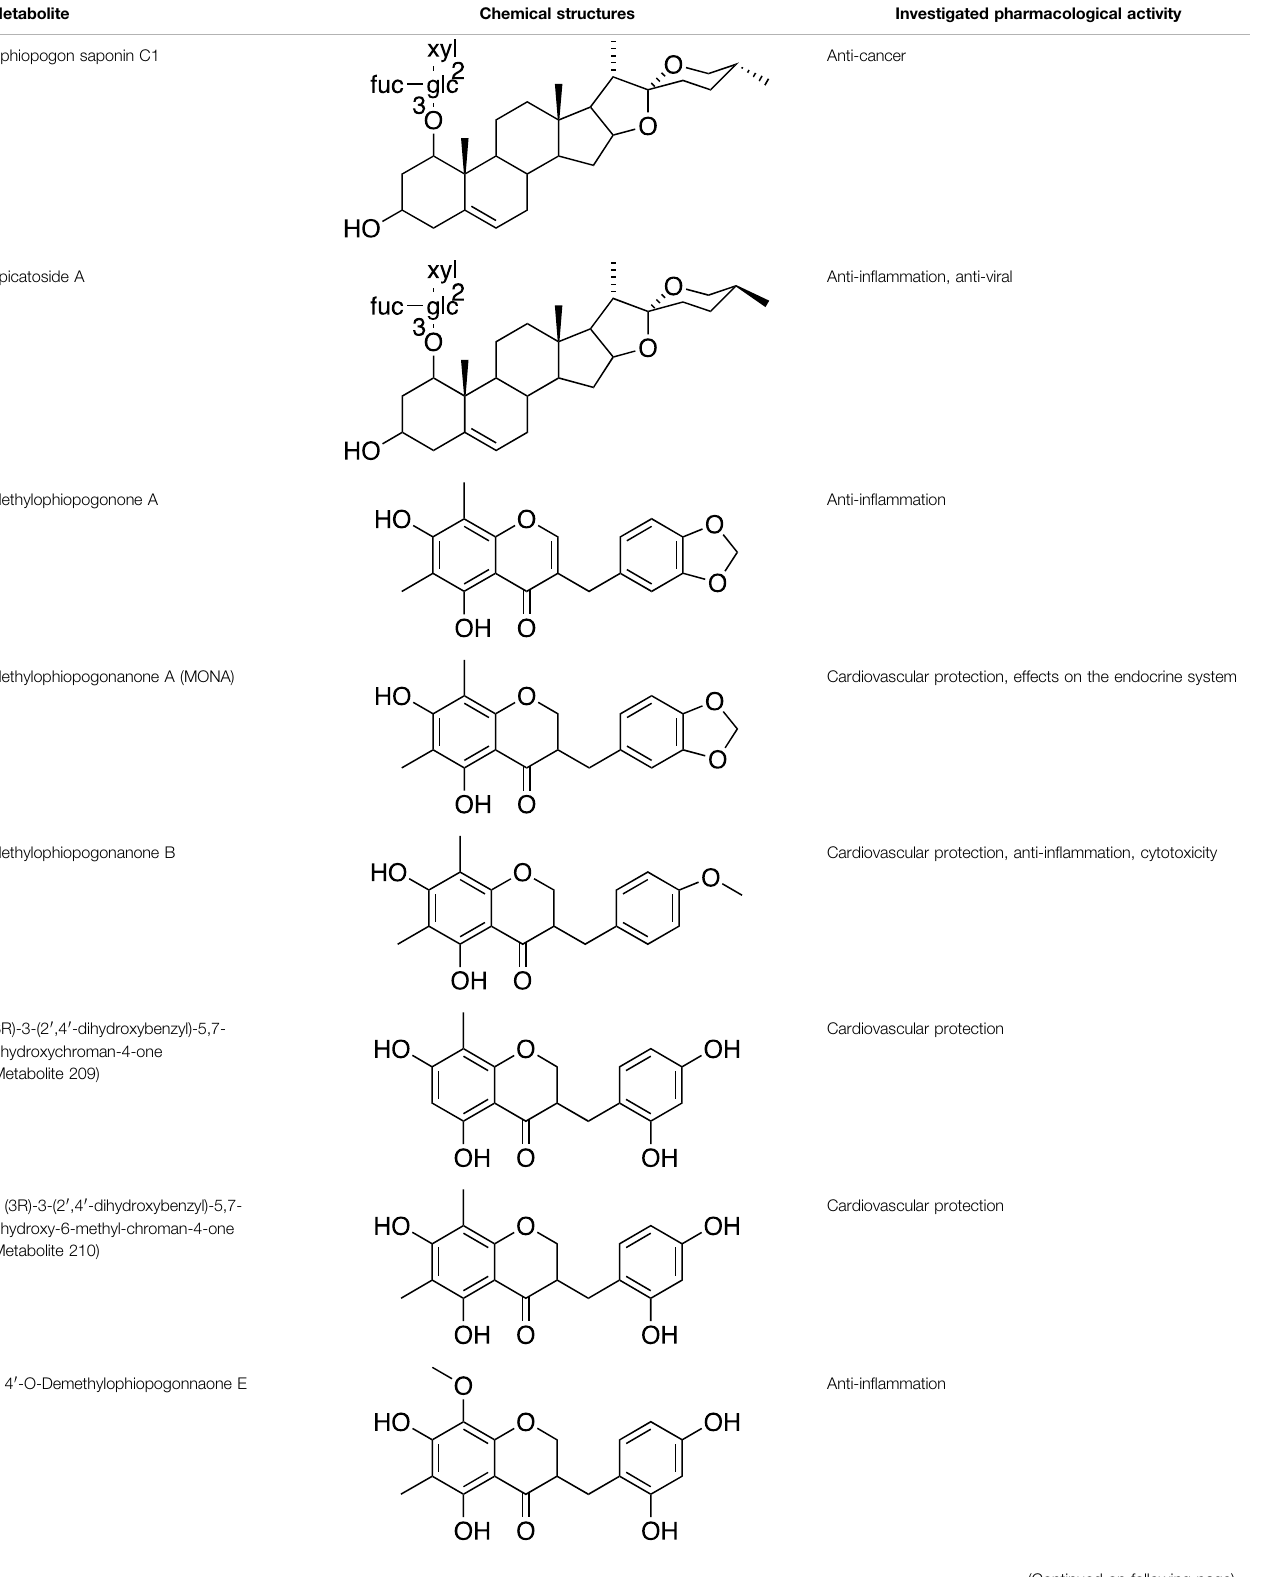
TABLE 2 | ( Continued ) Chemical structures of pharmacologically investigated metabolites with corresponding activities of liriopogons (details of activities can be found in Table